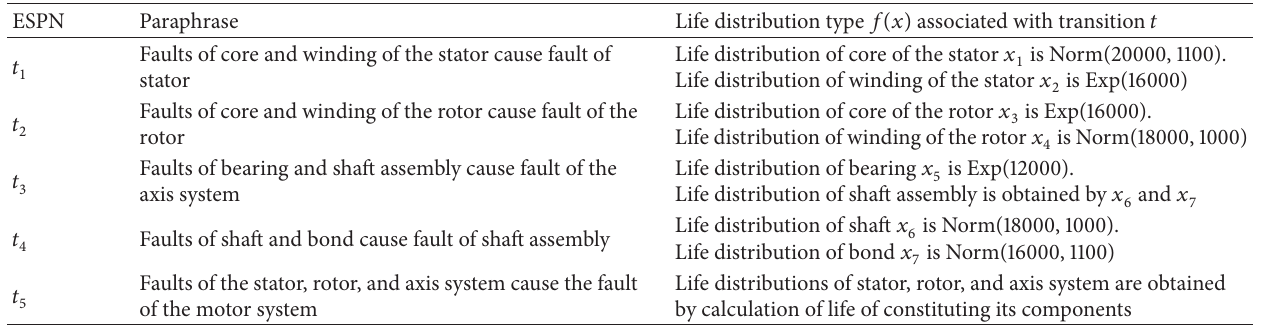
Table 2: Paraphrases of each transition in ESPN models.